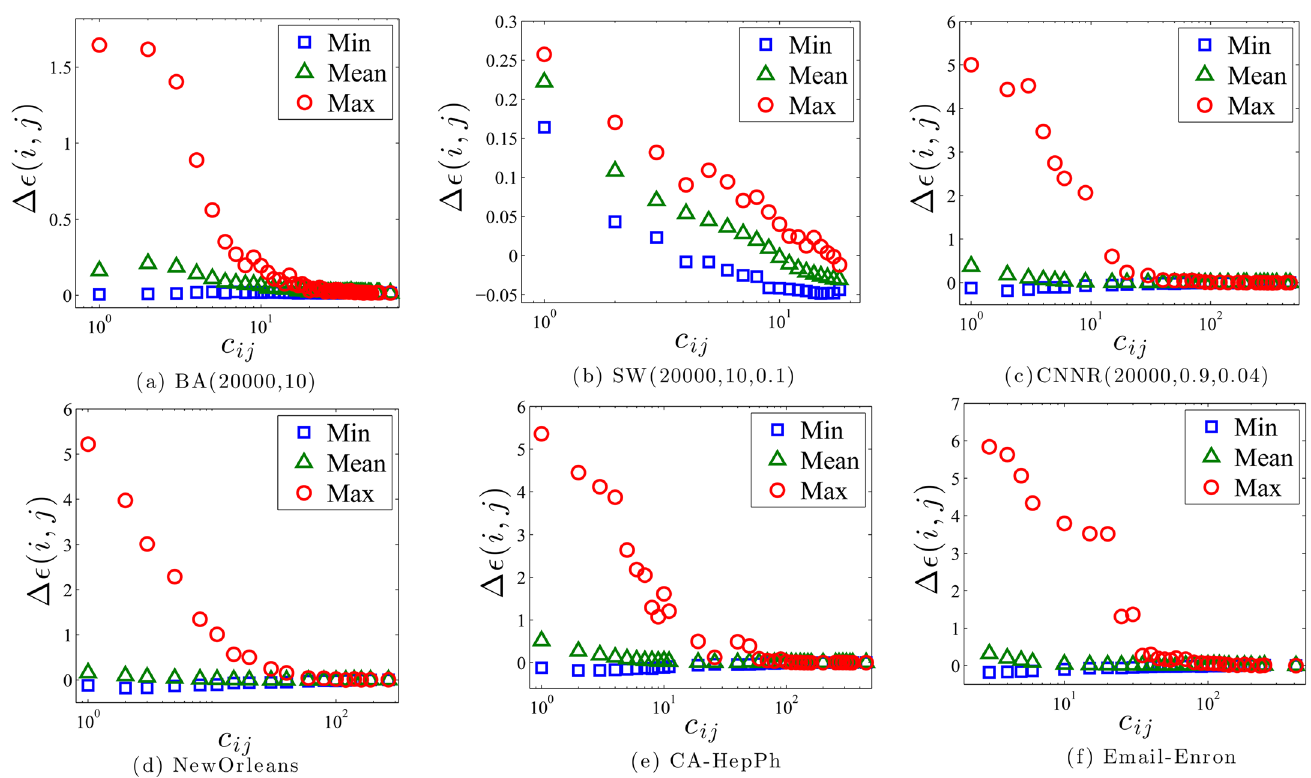
Fig 2. Empirical results from data sets. The results are consistent with the theory that increment of common friends would decrease the information entropy gain, especially for the maximum. Particularly, it should be also noted that as predicted by the analytical results, the averaged decay of Δ (cid:1) ( i , j ) is very small in some cases, as shown in Fig 2d. Note that there are several outliers for the maximum Δ (cid:1) ( i , j ), like in Fig 2c, which are produced by the noise in statistics. While the global trend of decrement with c ij in all networks is still significant.